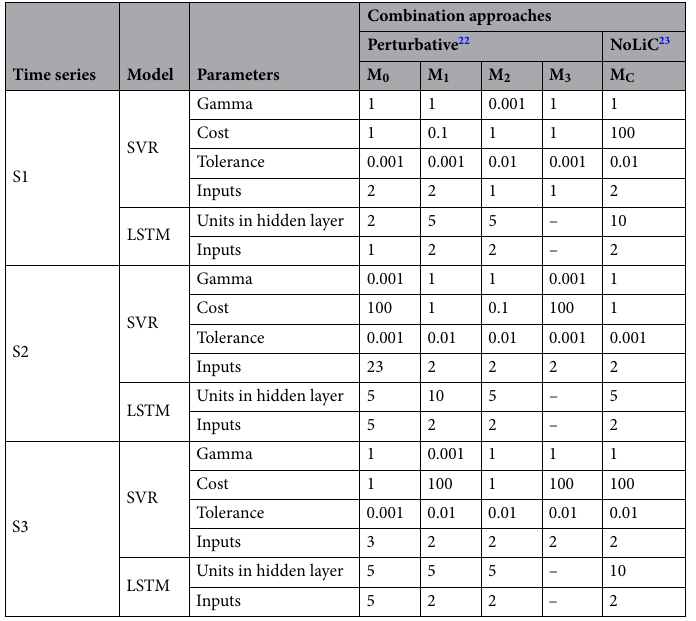
Table 3. Selected parameters for SVR and LSTM in the combination approaches using a grid search in the validation set for 1 day ahead SST